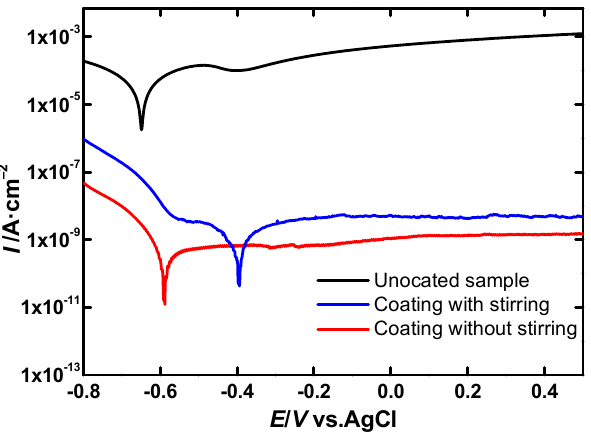
Figure 4. PDP curves in ASTM solution at a scan rate of 3 mV · s − 1 of lead coupons which were immersed in a 50 mM NaC 18 solution for 24 h.